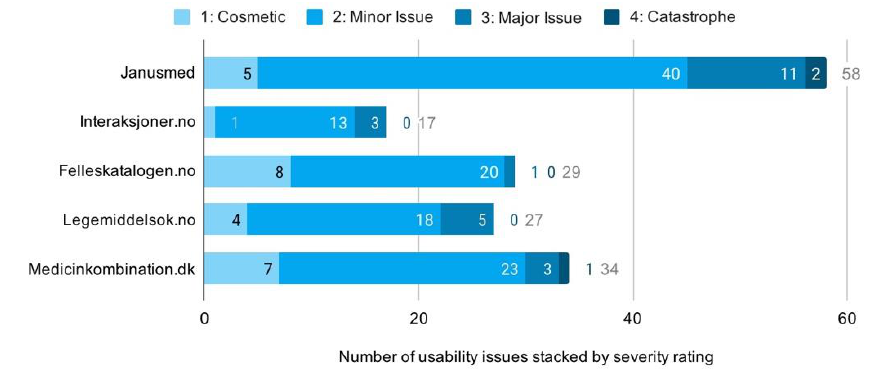
Figure 7. Distribution of usability issues across services.